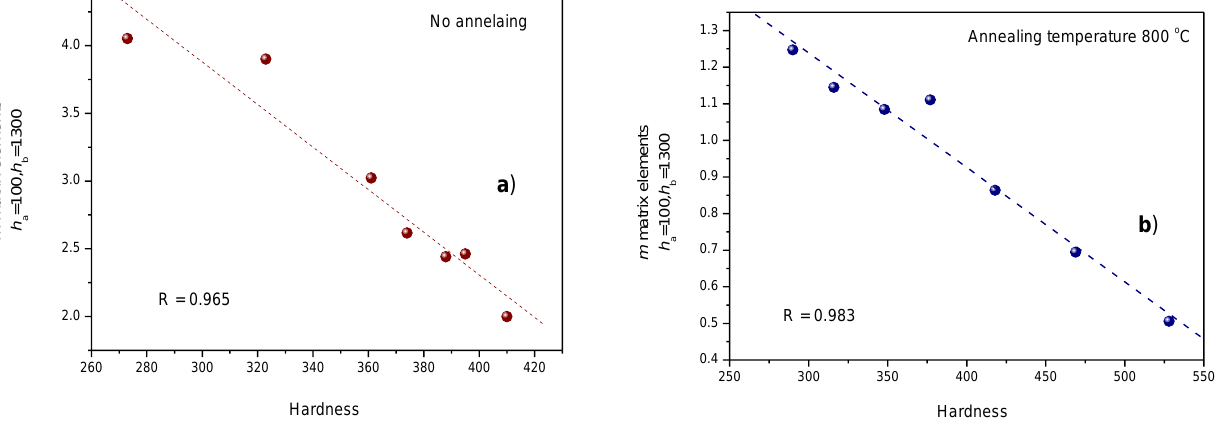
Figure 17. Saturation polarizations of all samples, indicating the actual heat treatments ( a ) and the rolling reductions ( b ) as functions of the hardness.